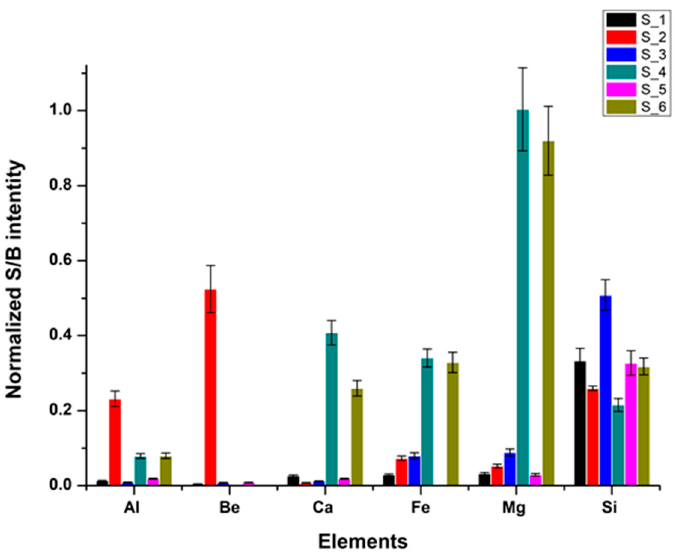
Figure 7. Normalized S/B ratio of the different elements present in all the investigated samples. Diopside and enstatite are inosilicates and belong to the group of pyroxenes. They represent end members of pyroxene quadrilateral (diopside–hedenbergite–enstatite–fer- rosilite). Diopside is a clinopyroxene while enstatite is an orthopyroxene. The composition of clinopyroxenes ranges between that of diopside and (MgCaSi 2 O 6 ) and hedenbergite (FeCaSi 2 O 6 ), whereas orthopyroxenes are a series between enstatite (MgSiO 3 ) and ferro- silite (FeSiO 3 ). LIB spectral data show that the Mg level in the S/B intensity ratio is higher